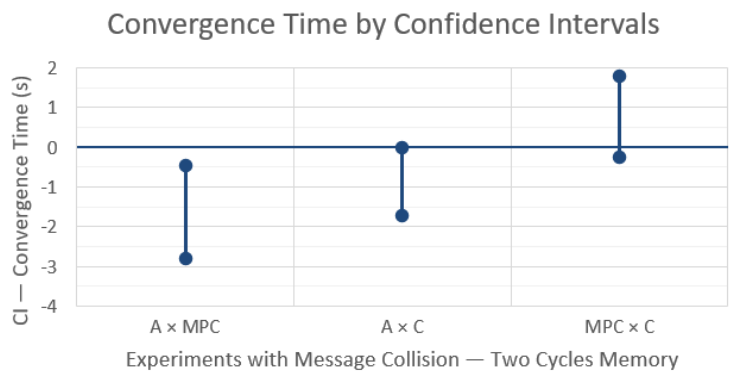
Figure 6. Differences in convergence time between the rendezvous techniques with 99% confidence intervals and message losses, with two communication cycles memory.